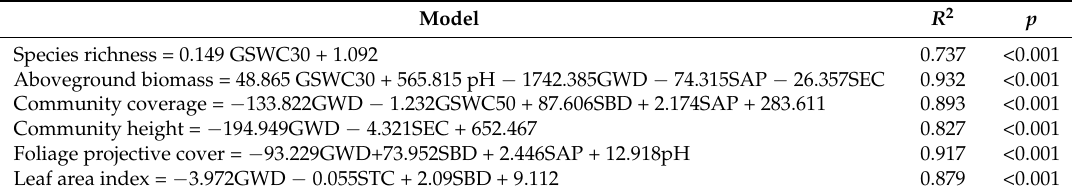
Table A3. Summary Multivariate stepwise regression between community characteristics and environment factors. Other abbreviations are given in Table